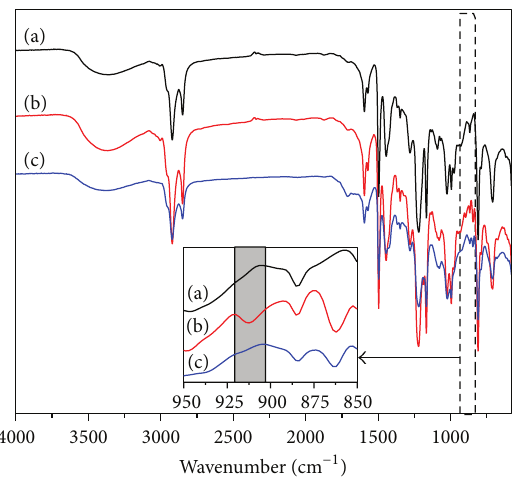
Figure 4: FTIR spectra of samples ((a) UFUR; (b) TMBPDE-15 (uncured); (c) TMBPDE-15 (cured)).